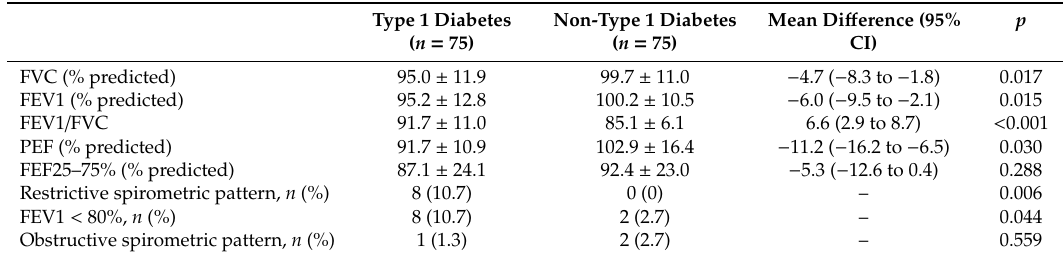
Table 3. Main pulmonary function variables and breathing patterns of the study population according to the presence of type 1